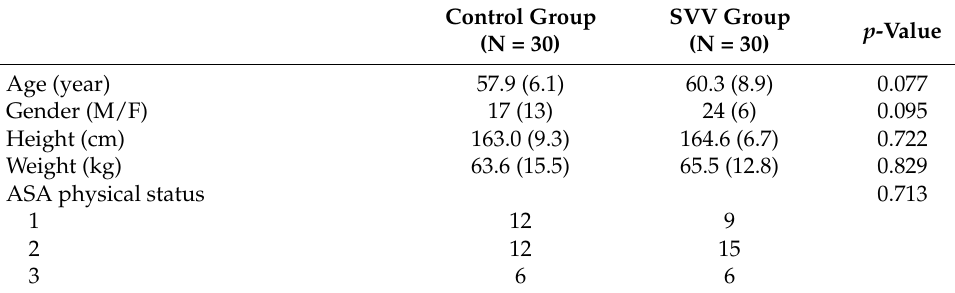
Figure 1. CONSORT diagram. Table 1. Demographic